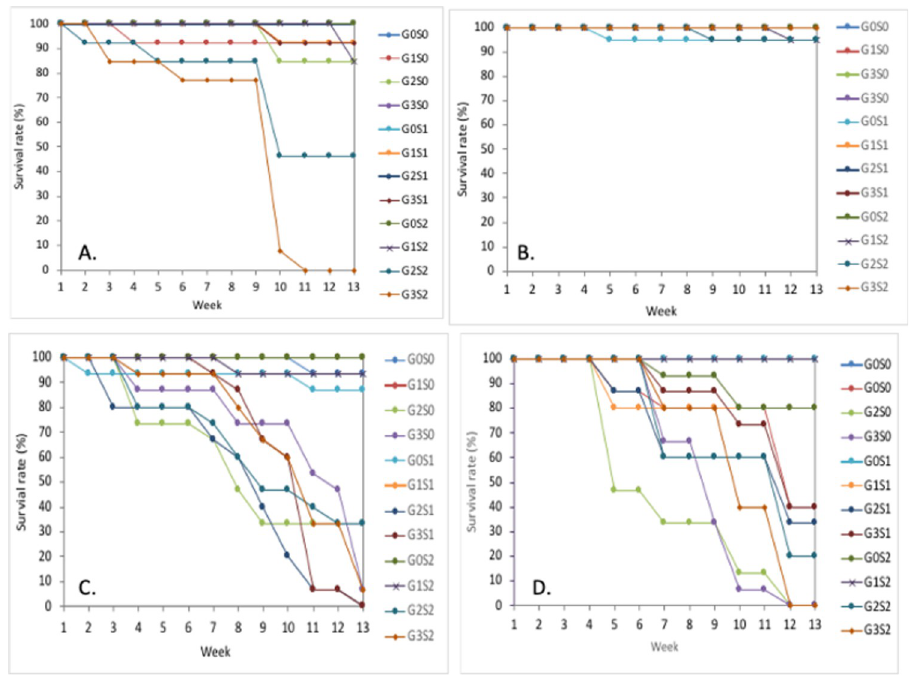
Fig 2. Survival rate of four tropical peatland tree species. A) Cratoxylum arborescens , B) Shorea balangeran , C) Nephelium lappaceum , D) Durio zibethinus , in treatment combination of shading and saturated condition. G0S0 = Freely drained 0% shading, G0S1 = Freely drained with 30% shading, G0S2 = Freely drained with 70% shading, G1S0 = GW level 10 cm 0% shading, G1S1 = GW level 10 cm with 30% shading, G1S2 = GW level 10 cm with 70% shading, G2S0 = GW level zero 0% shading, G2S1 = GW level zero with 30% shading, G2S2 = GW level zero with 70% shading, G3S0 = ⅓ stem height flooding 0% shading, G3S1 = ⅓ stem height flooding with 30% shading, G3S2 = ⅓ stem height flooding with 70% shading.